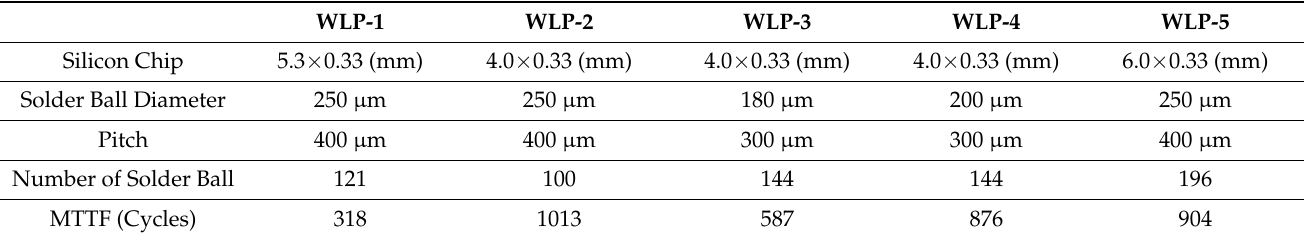
Table 1. Dimension of WLP test vehicles